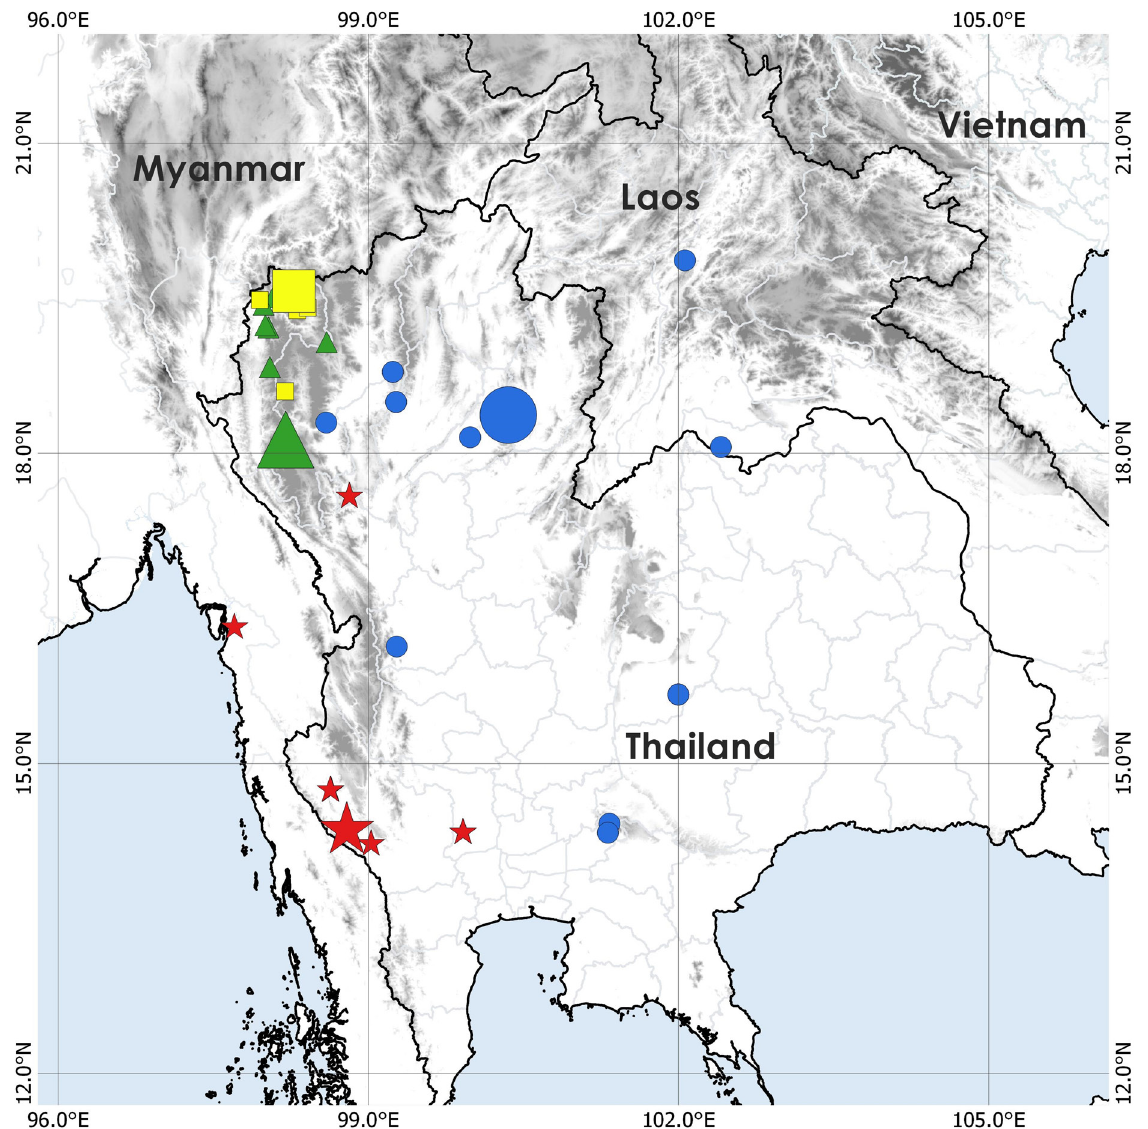
Fig. 6. Distribution range of G. aranyaniae Sangvir. & M.F.Newman sp. nov. (circles), G. flagellaris K.Larsen (squares), G. lithophila Sangvir. & M.F.Newman sp. nov. (triangles), G. macrochila Sangvir. & M.F.Newman sp. nov. (stars). The type locality of each species is indicated by a bigger